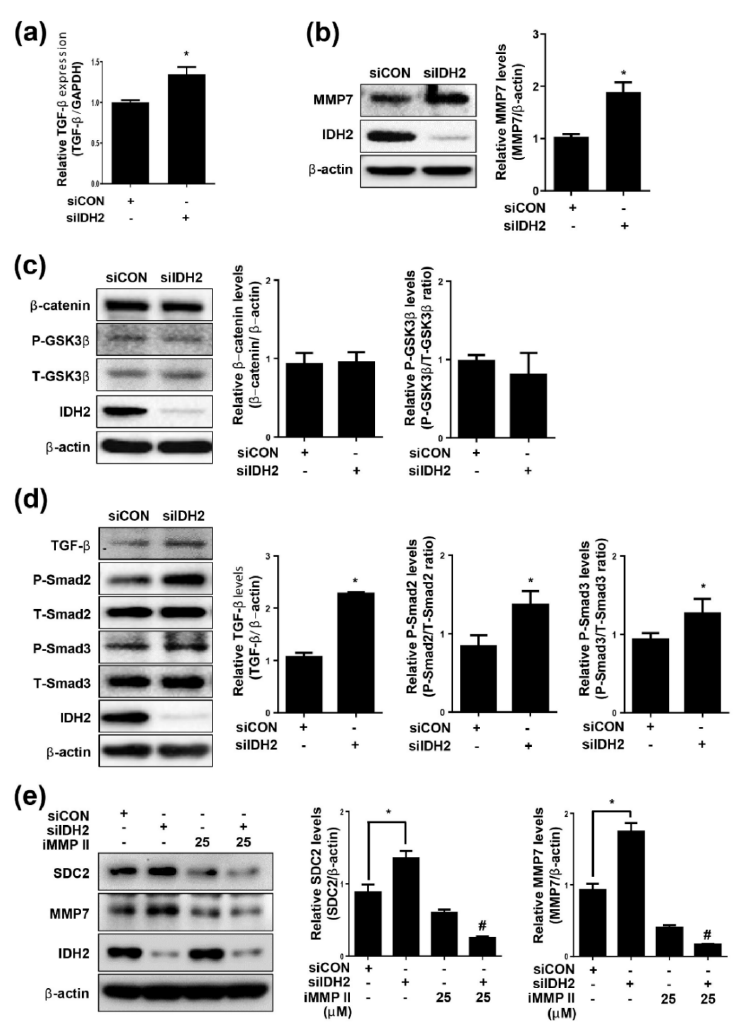
Figure 2. Involvement of TGF- β and MMP7 signaling in relation to SDC2 shedding in IDH2 deficient HUVECs. HUVECs were transfected with 50 pmol of siIDH2 and siCON for 48 h. ( a ) mRNA expression of TGF- β was quantified by qPCR. Protein levels of ( b ) MMP7 ( c ) β -catenin and ( d ) TGF- β signaling-related proteins were detected by we stern blotting. β -actin was used as a loading control. Protein levels were quantified by densitometric analysis using Image-J software (Shown in the right panel). HUVECs were transfected with 50 pmol of siIDH2 and siCON, incubated for 24 h and treated with MMP inhibitor II (25 μM) for another 24 h. Protein levels of ( e ) MMP7 and SDC2 were detected by western blotting. β -actin was used as a loading control. Protein levels were quantified by densitometric analysis using Image-J software (Shown in the right panel). All data are presented as means ± SEM of three independent experiments, * p < 0.05, compared with siCON, # p < 0.05 compared with the 50 pmol siIDH2 treated cells.